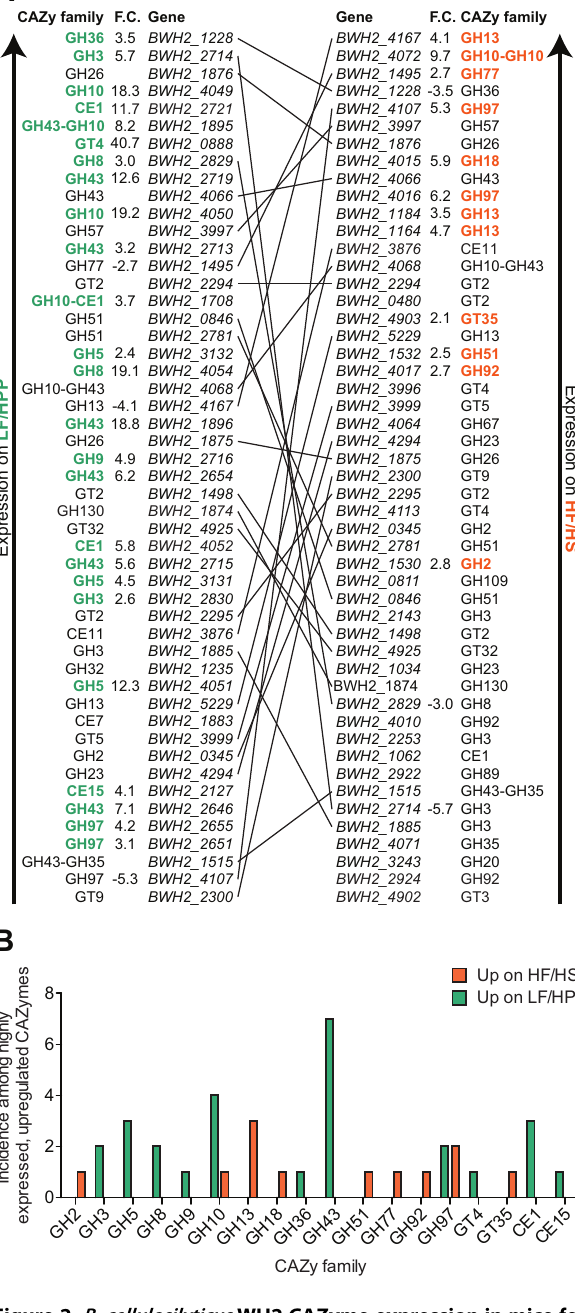
Figure 2. B.cellulosilyticus WH2 CAZyme expression in mice fed different diets. (A) Overview of the 50 most highly expressed B. cellulosilyticus WH2 CAZymes (GHs, GTs, PLs, and CEs) for samples from each diet treatment group. List position denotes the rank order of gene expression for each treatment group, with higher expression levels situated at the top of each list. Genes common to both lists are identified by a connecting line, with the slope of the line indicating the degree to which a CAZyme’s prioritized expression is increased/ decreased from one diet to the other. CAZy families in bold, colored letters highlight those list entries found to be significantly up-regulated relative to the alternative diet (i.e., a CAZyme with a bold green family designation was up-regulated on the LF/HPP diet; a bold orange family name implies a gene was up-regulated significantly on the HF/HS diet). Statistically significant fold-changes between diets are denoted in the ‘‘F.C.’’ column (nonsignificant fold-changes are omitted for clarity).